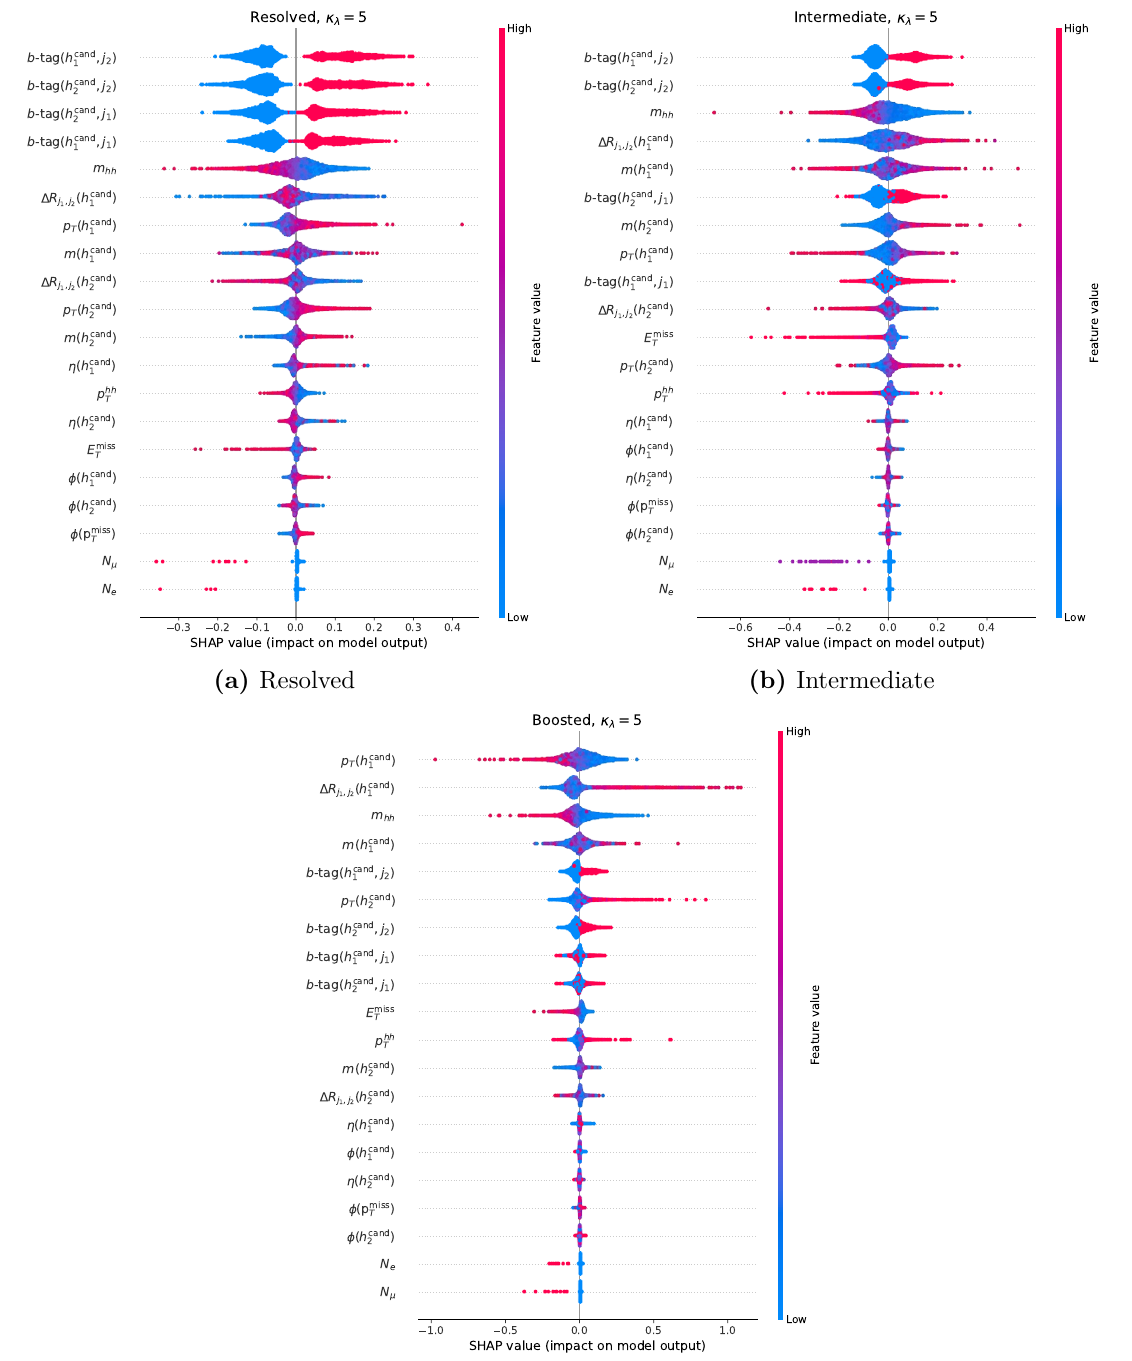
Figure 10. SHAP value plots representing ranked variable (feature) importance for the DNN trained on κ λ = 5 signals in the (a) resolved, (b) intermediate and (c) boosted categories. The input variables are ranked in descending order by their average absolute SHAP value plotted on the x -axis. The colour scale indicates the value of the variable on the specific event for which the SHAP value is plotted. Analogous plots for the DNN trained on κ λ = 1 are found in appendix